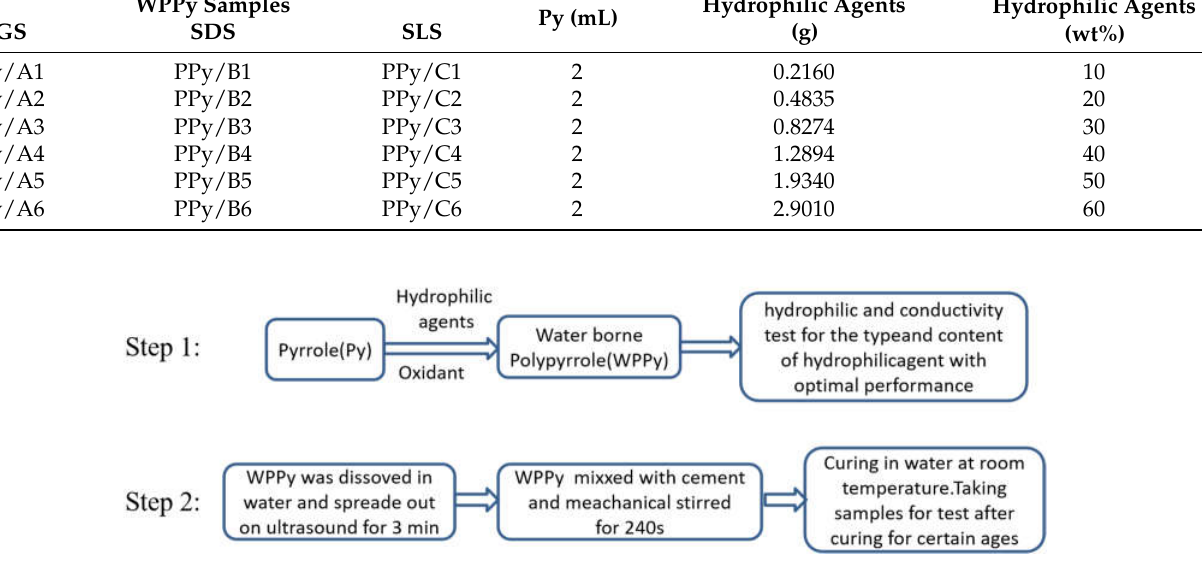
Figure 1. Experimental protocol employed to synthesize WPPy and WPPy/cement composites. Table 1. Polymerization formulas.